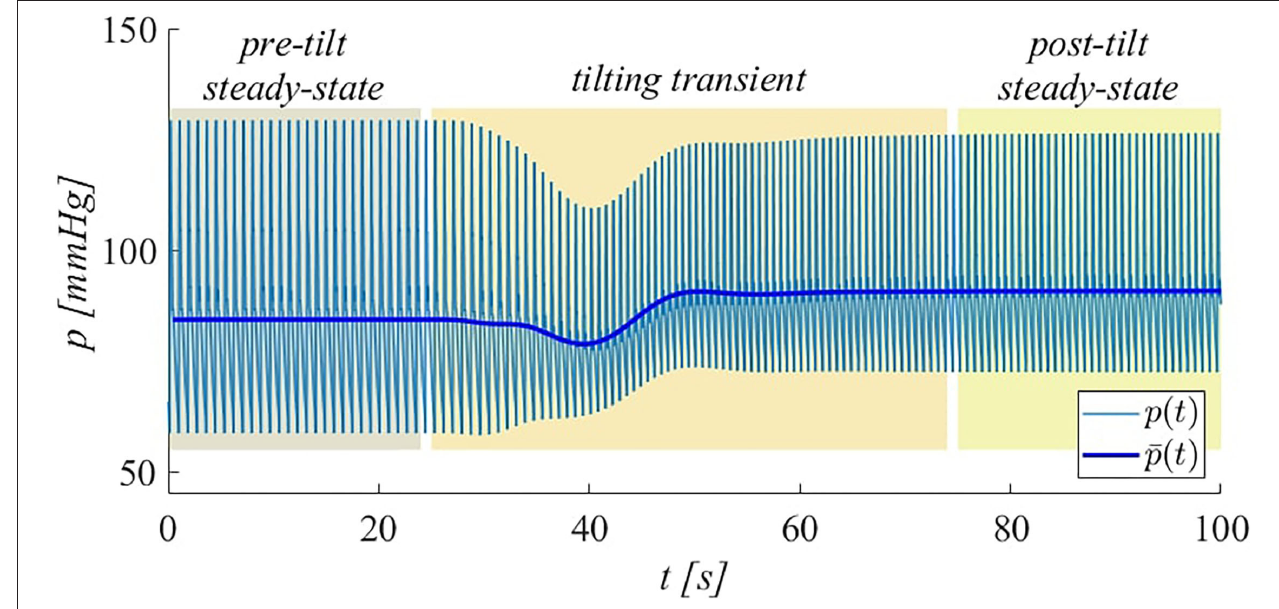
FIGURE 2 | Illustration of simulated brachial pressure behavior during HUT to 70 ◦ at 4 ◦ /s. Both instantaneous ( p ) and beat-averaged ( ¯ p ) pressure signals are shown. The intervals corresponding to pre-tilt steady-state, tilting transient, and post-tilt steady-state are